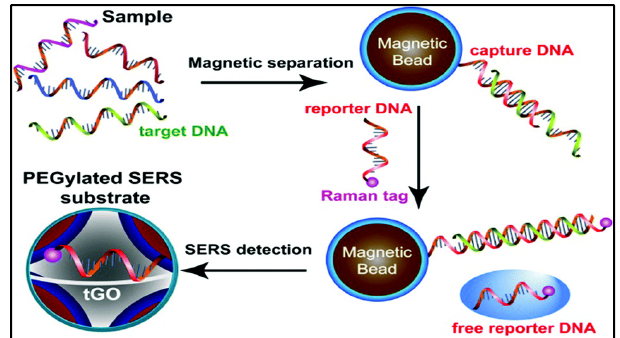
Figure 9. Mechanistic illustration of graphene-based substrates for SERS optical sensing. Image reprinted with permission from [119], under https://creativecommons.org/licenses/by-nc/3.0/, accessed on 26 November